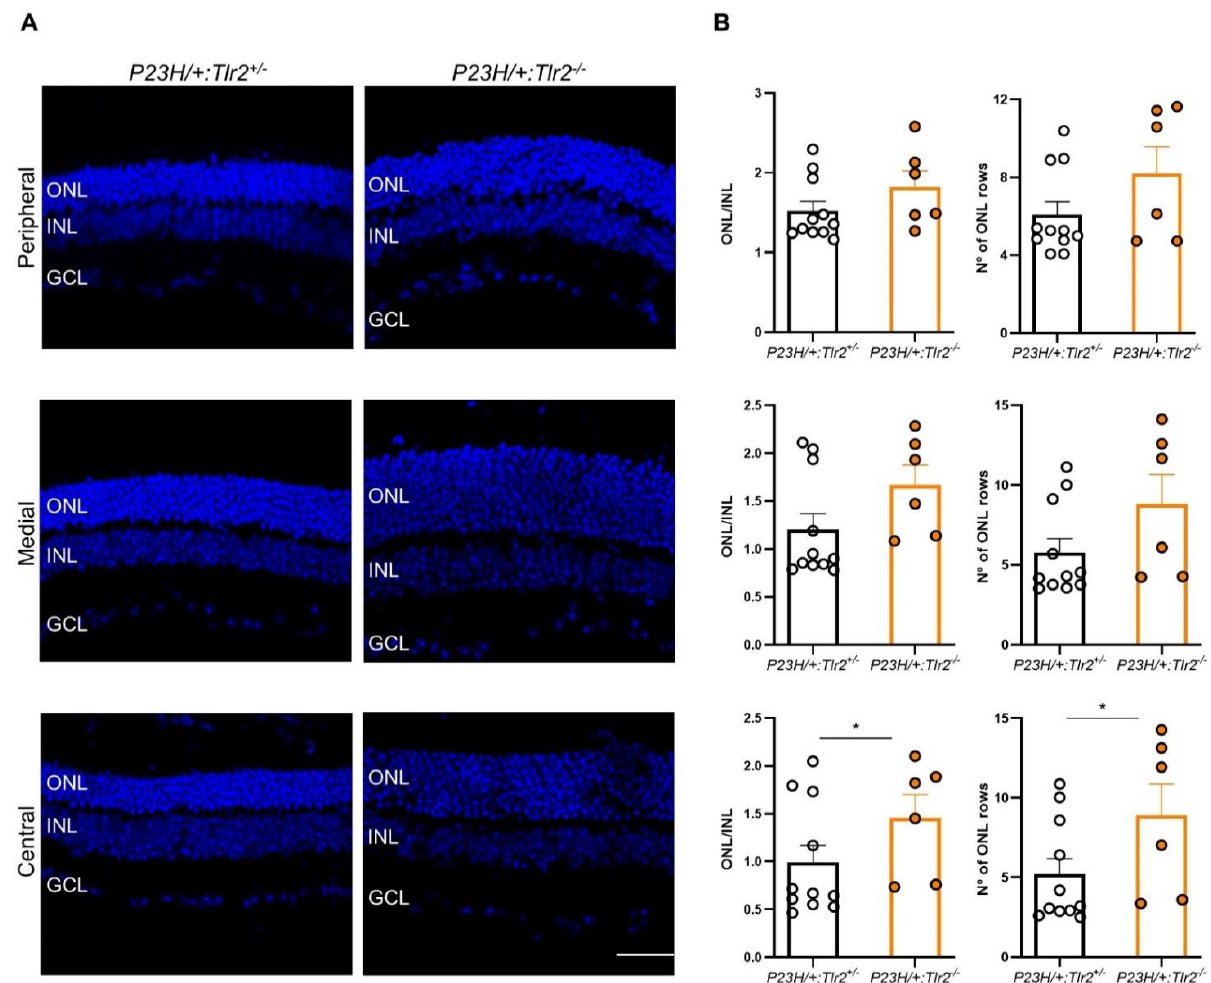
Figure 5. Retinal structure analysis in P23H/+ : Tlr2 +/ − and P23H/+ : Tlr2 − / − mice. ( A ) Representative images of peripheral, medial, and central retinal areas in cryosections from 4-month-old P23H/+ : Tlr2 +/ − and P23H/+ : Tlr2 − / − mice. Nuclei were stained with DAPI (blue). ONL, outer nuclear layer; INL, inner nuclear layer; GCL, ganglion cell layer. Scale bar: 31 µ m. ( B ) ONL and INL thickness were measured in equatorial sections corresponding to the peripheral, medial, and central retina (see Methods section). The number of photoreceptor rows was also scored in these same regions. Dots represent individual mice and bars represent the mean (+SEM) for each group. n = 6–11 animals per group (5 sections per retina, 2 images per section in each area, 3 measurements per image). * p < 0.05 (Mann-Whitney U -test).